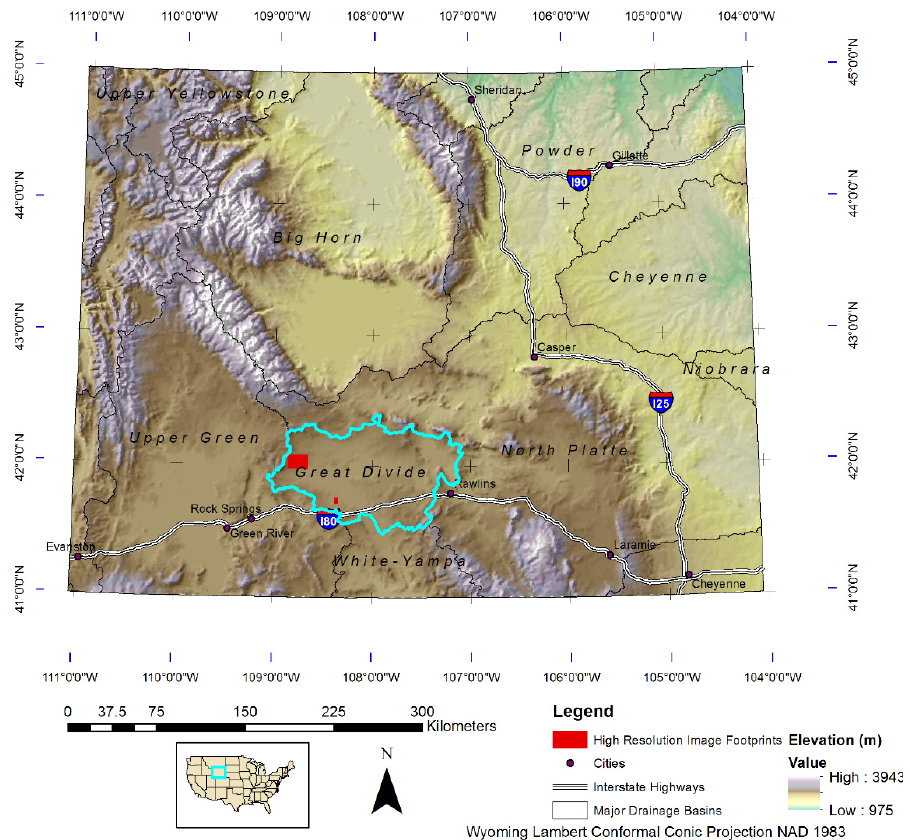
Figure 1. The Great Divide Basin in southwestern Wyoming (highlighted in blue).